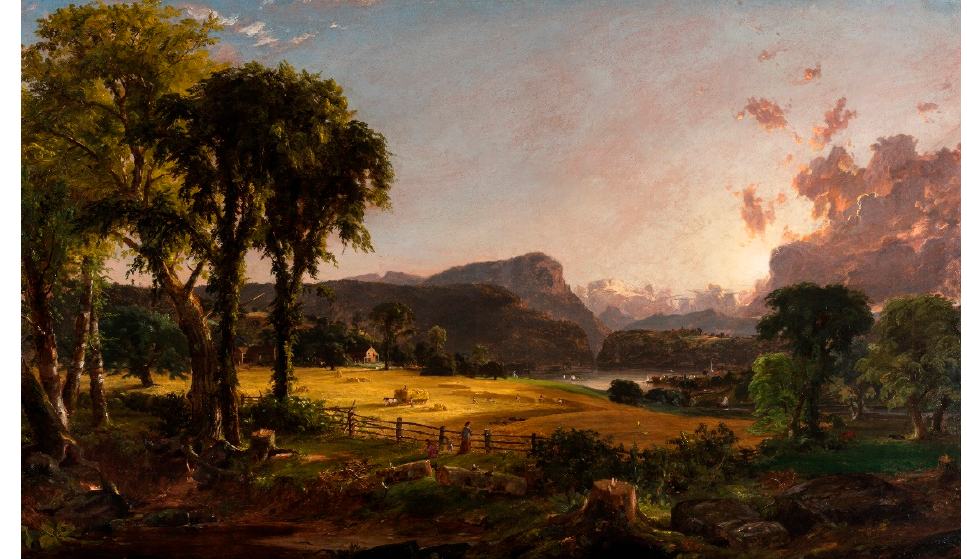
Figure 2. Jasper Francis Cropsey, American, 1823–1900. American Harvesting , 1851. Oil on Canvas. 35 ½ × 52 ¾ inches. Gift of Mrs. Nicholas H. Noyes, Eskenazi Museum of Art, Indiana University, 69.93.